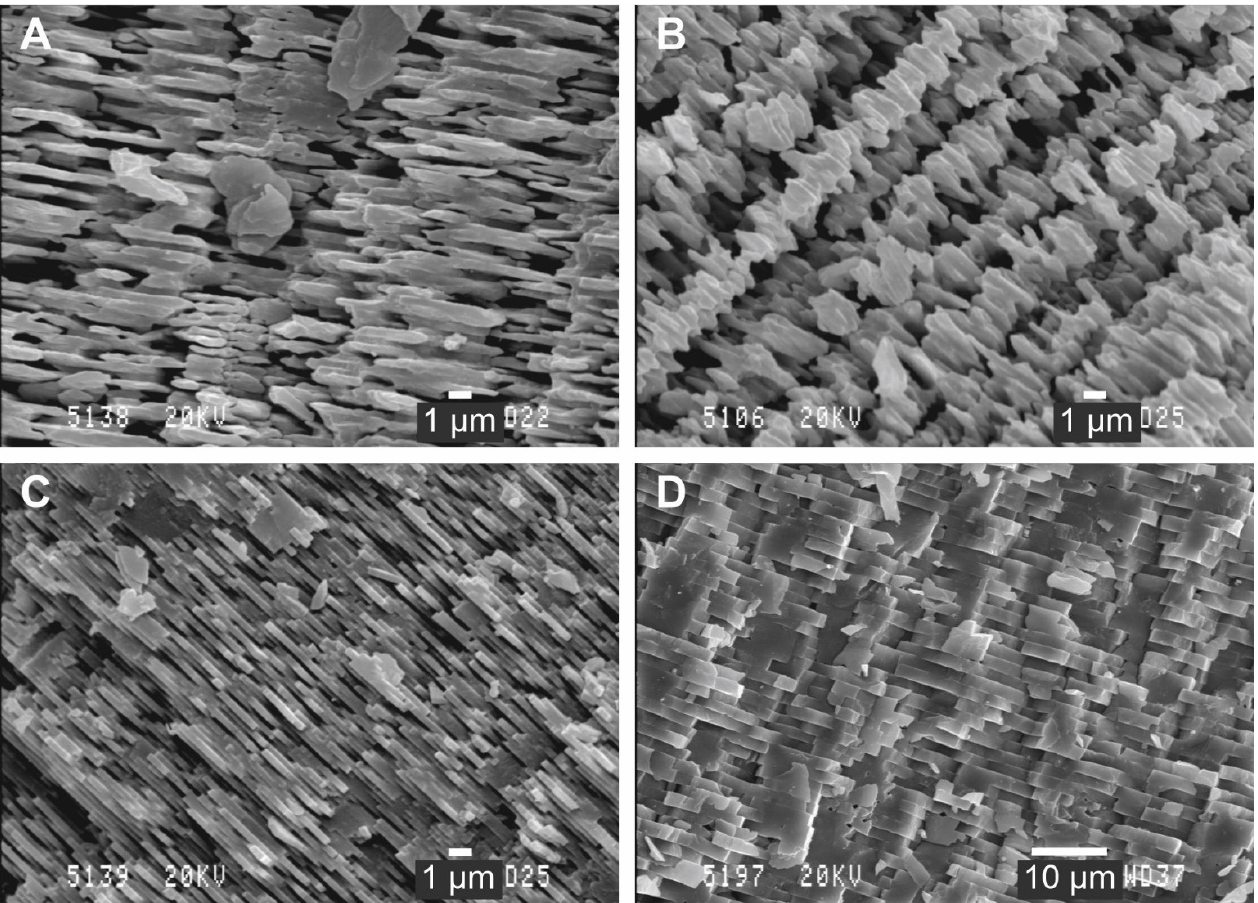
Figure 2. SEM photomicrographs of the microstructure of nacreous layer of Middle Bathonian (Middle Jurassic) aragonitic shells from central Poland (studied for stable isotopes by Wierzbowski and Joachimski [78]). ( A ) Partially dissolved ammonite shell. ( B ) Strongly dissolved ammonite shell. ( C ) Well-preserved ammonite shell. ( D ) Well-preserved bivalve ( Trigonia ) shell.